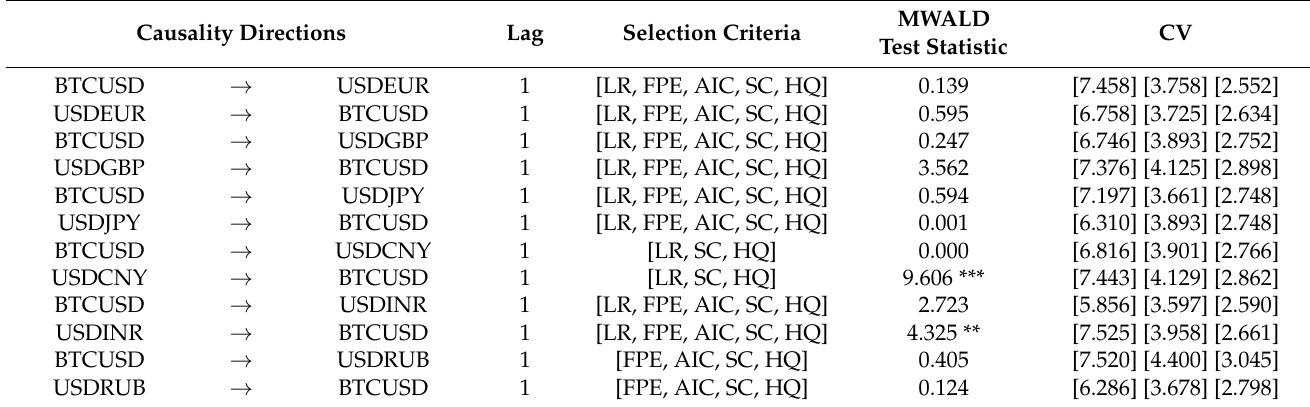
Table 3. Hacker-Hatemi Modified Wald